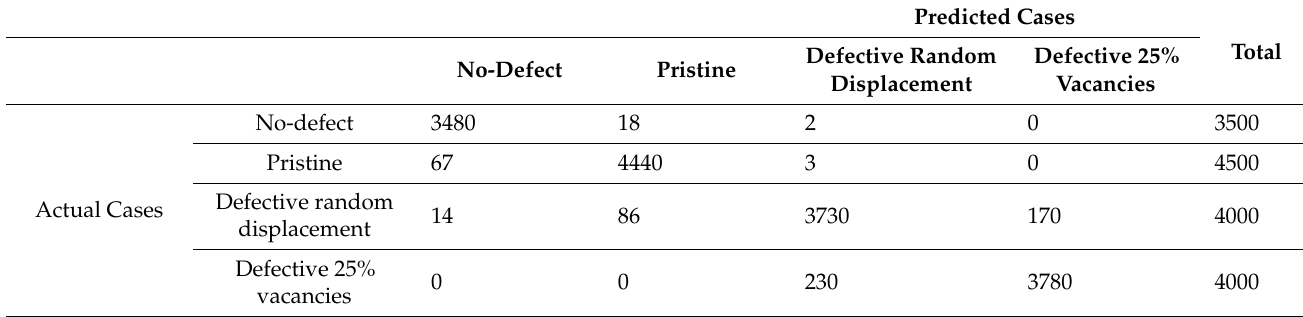
Table 2. Exper-1 confusion matrix for Dns-Net with the transfer learning.